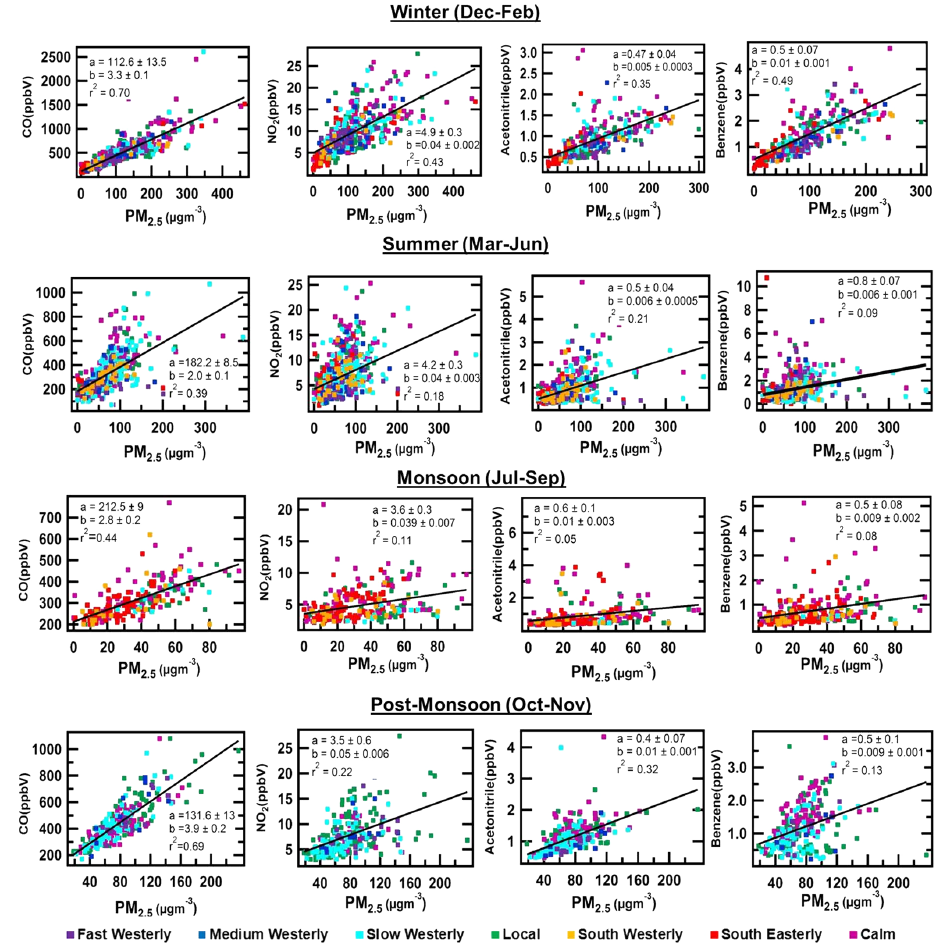
Figure 8. Scatter plots of fine-mode PM with CO, acetonitrile, benzene and NO 2 for the winter, summer, monsoon and post-monsoon seasons. a stands for intercept and b stands for slope in the linear regression